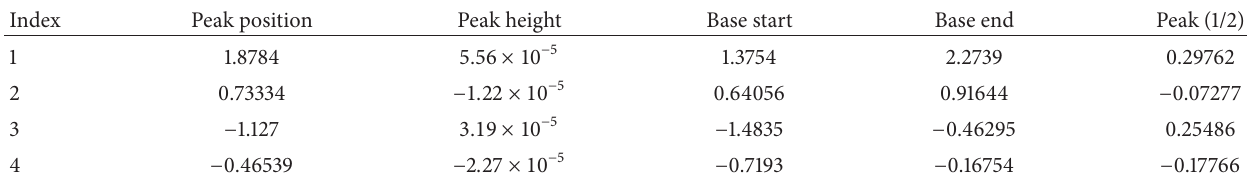
Table 6: Antibacterial activities of the Mn(II) ditolyldithiophosphates (zone of inhibition, in mm).